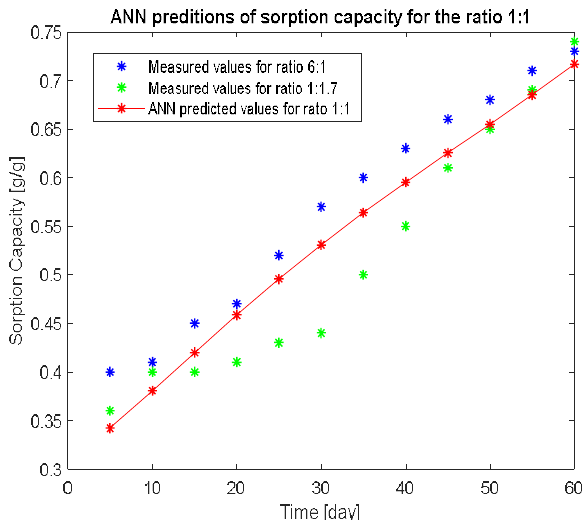
Figure 9. ANN predictions of the sorption capacity at a new shungite and rice husk ratio of 1:1 for the 15% oil-contaminated soil .